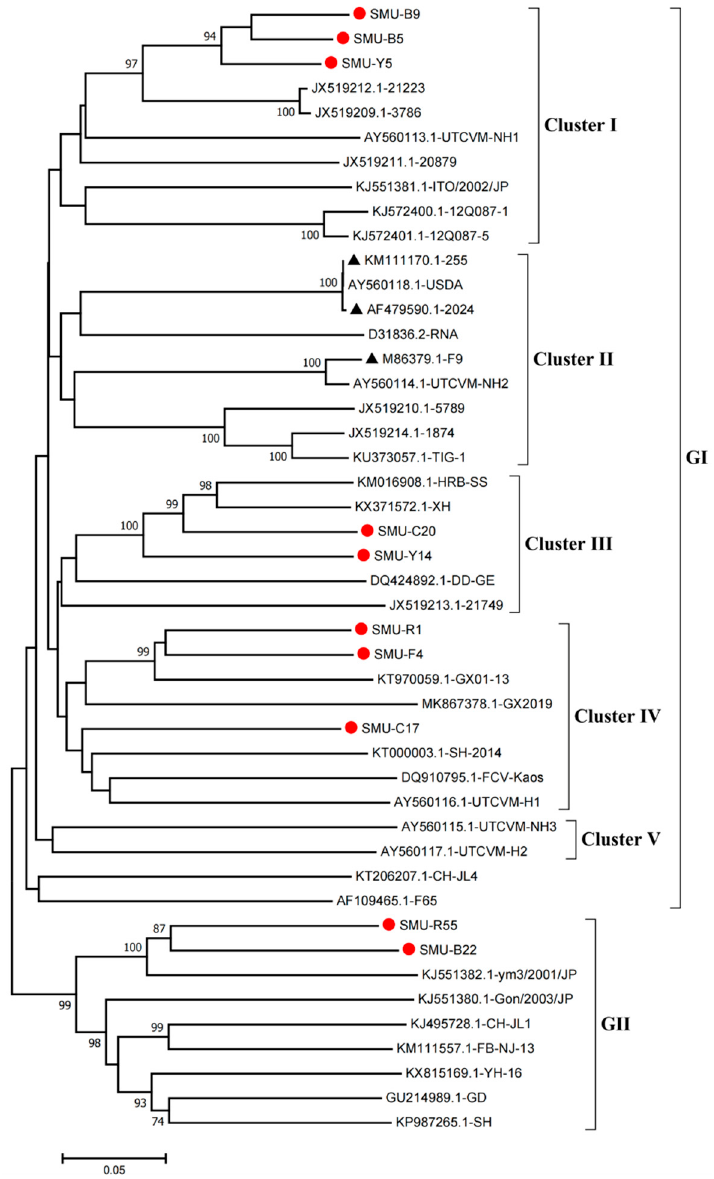
Figure 1. Phylogenetic tree of FCVs from southwestern China and 35 reference strains based on nucleotide sequences of VP1 HV. The phylogenetic tree was constructed with MEGA7.1 software (Tempe, AZ, USA) by the neighbor-joining method with 1000 bootstrap values. The viral assembly sequences characterized in this study are marked by “red circles” and the vaccine strains are labeled with “black triangles”. The scale bar indicates the number of nucleotide substitutions per site.